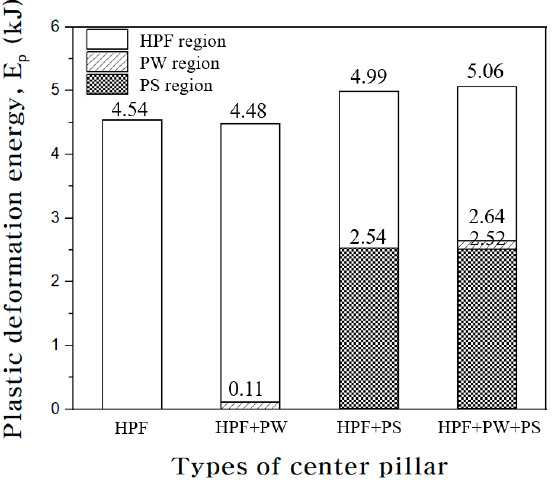
Figure 15. Maximum plastic deformation energy ( E p ) of the four types of center pillar.